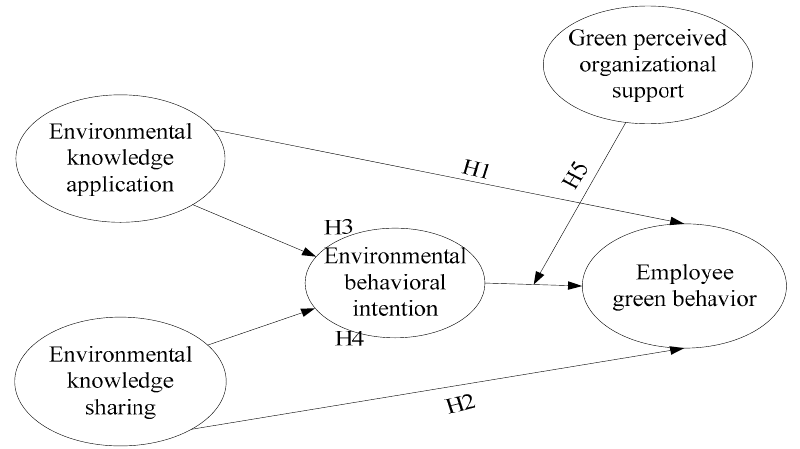
Figure 1. The conceptual model. Source: edited by authors.